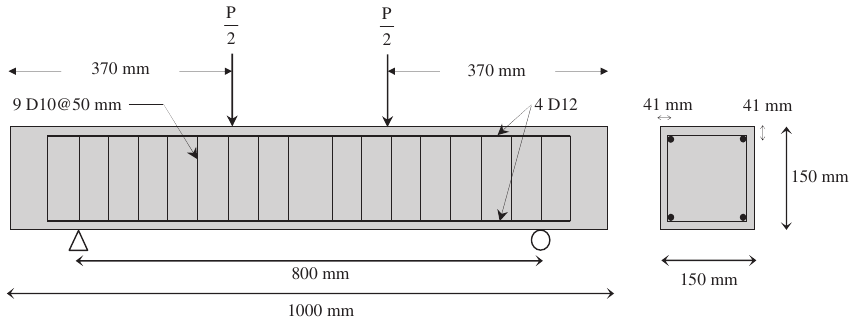
Figure 1: Typical geometry of a concrete beam and reinforcement